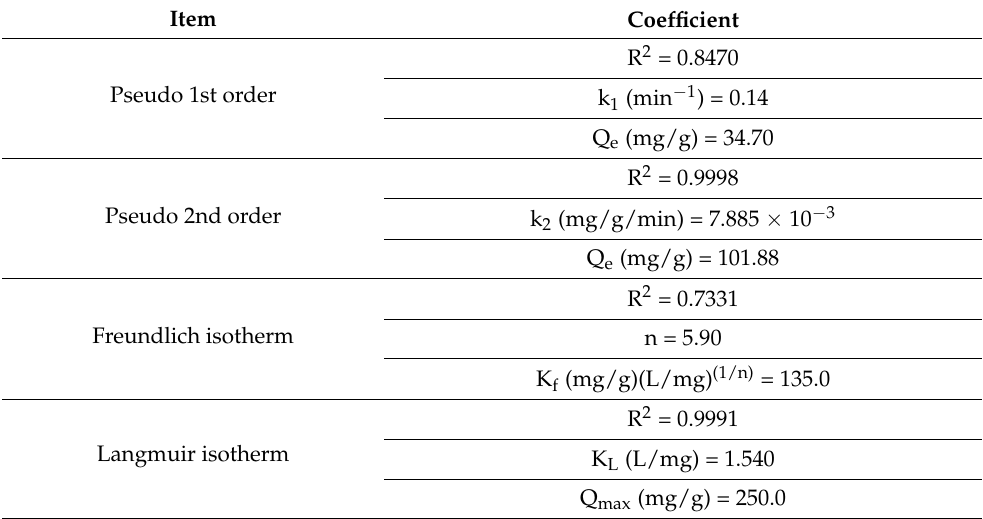
Table 1. The adsorption isotherm and kinetic parameters for the adsorption of Pb 2+ ions on the surface of Fe 3 O 4 /N@C nanocomposite.